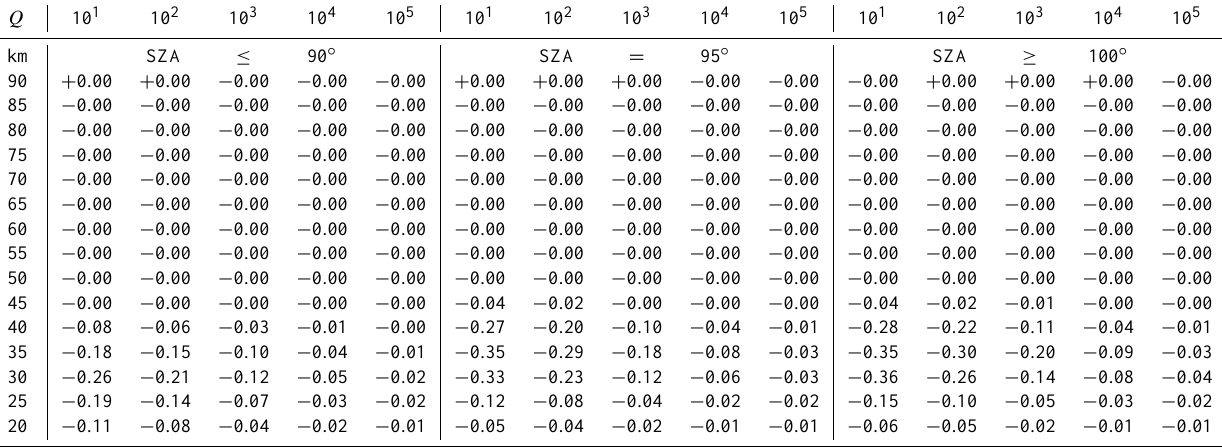
/Q for January NH. 2 O 5